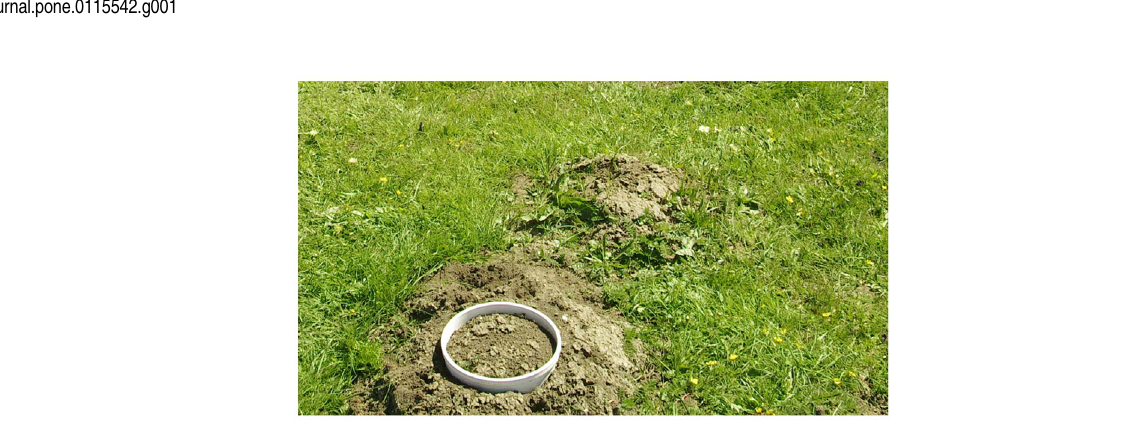
Fig. 2. PVC tube place over the plateau zokor hummocks in the Zoige peatlands.